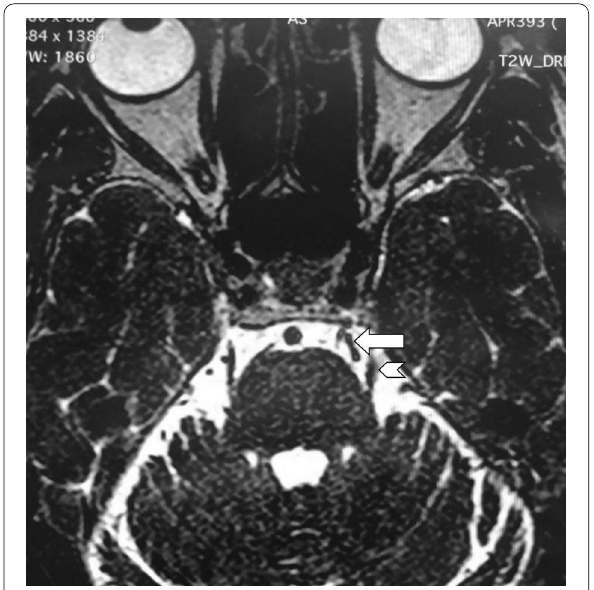
Fig. 2 Preoperative axial MRI with constructive interference in steady state showing the offending vascular loop (long arrow) near the left trigeminal nerve complex (short arrow)